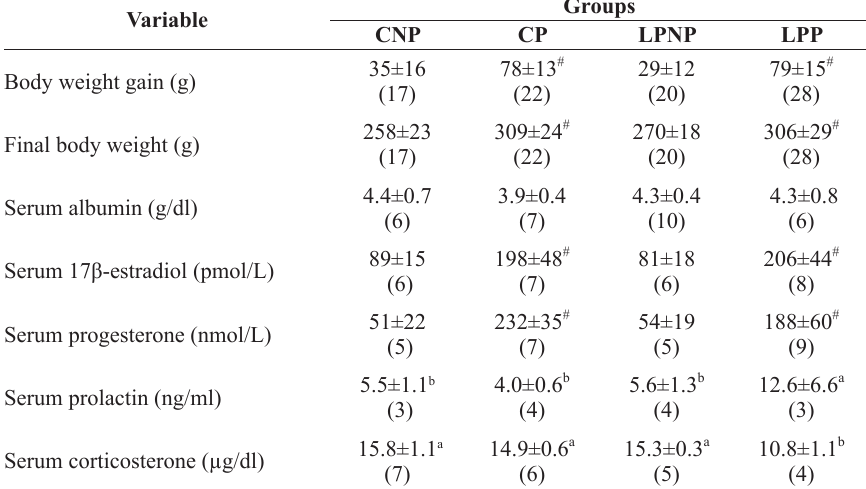
Values represent the means ± SDs for the number of rats shown in parentheses. # Indicates differences in relation to non-pregnant rats (Two-way ANOVA, P <0.05). a,b Mean values with unlike superscript letters were significantly different (LSD test; P <0.05).